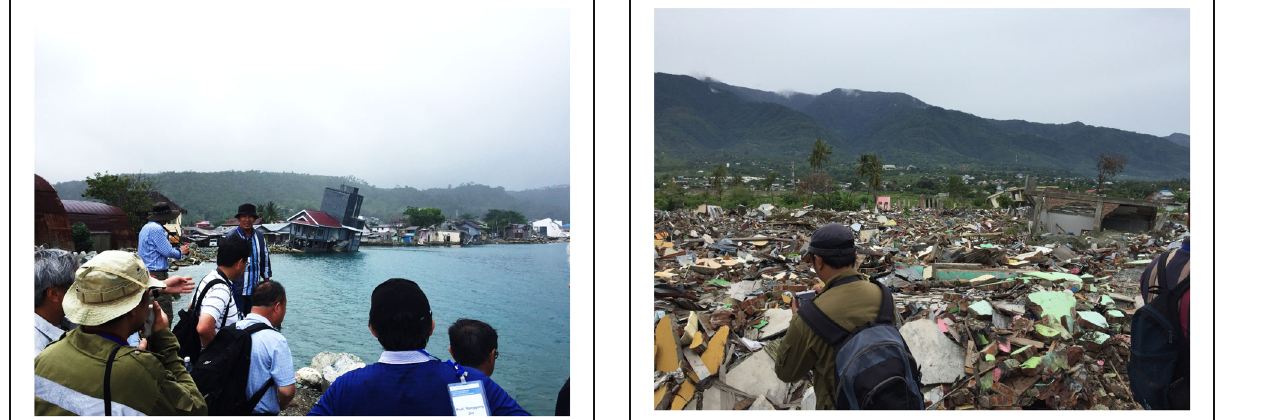
Fig. 4 A sunken village in Donggala Fig. 6 Rumbles in